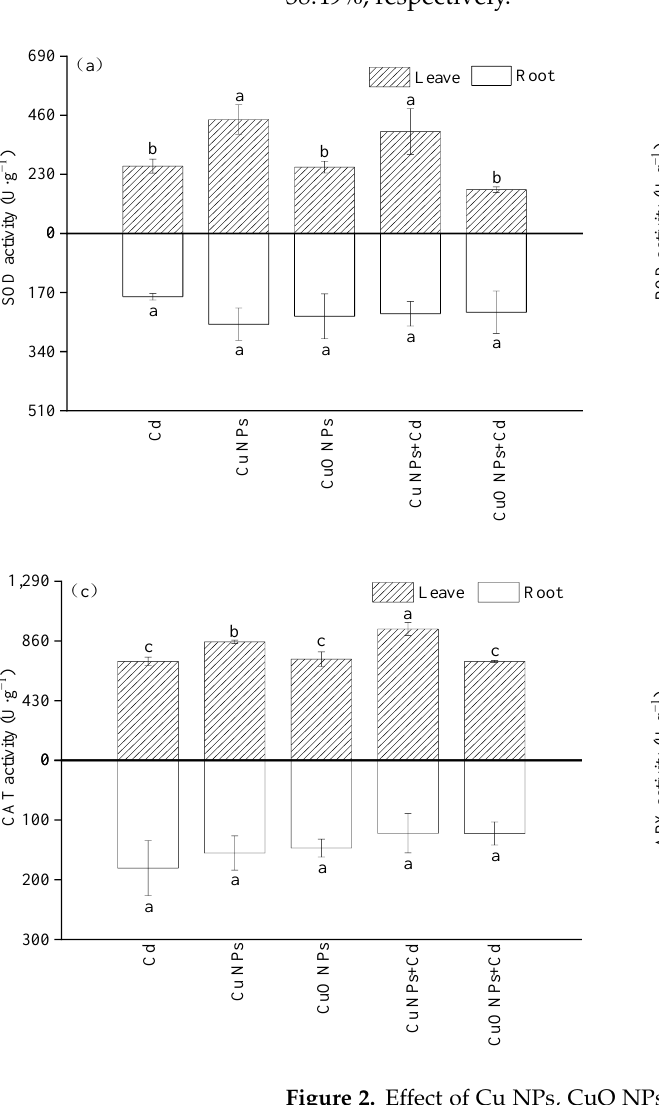
Figure 2. Effect of Cu NPs, CuO NPs and Cd on SOD activity ( a ), POD activity ( b ), CAT activity ( c ) and APX activity ( d ) of Brassica . The means are averaged from three replicates, and the error bars correspond to the standard deviations of the three values. Different letters above each column indicate a significant difference among treatments in the same group ( p < 0.05).